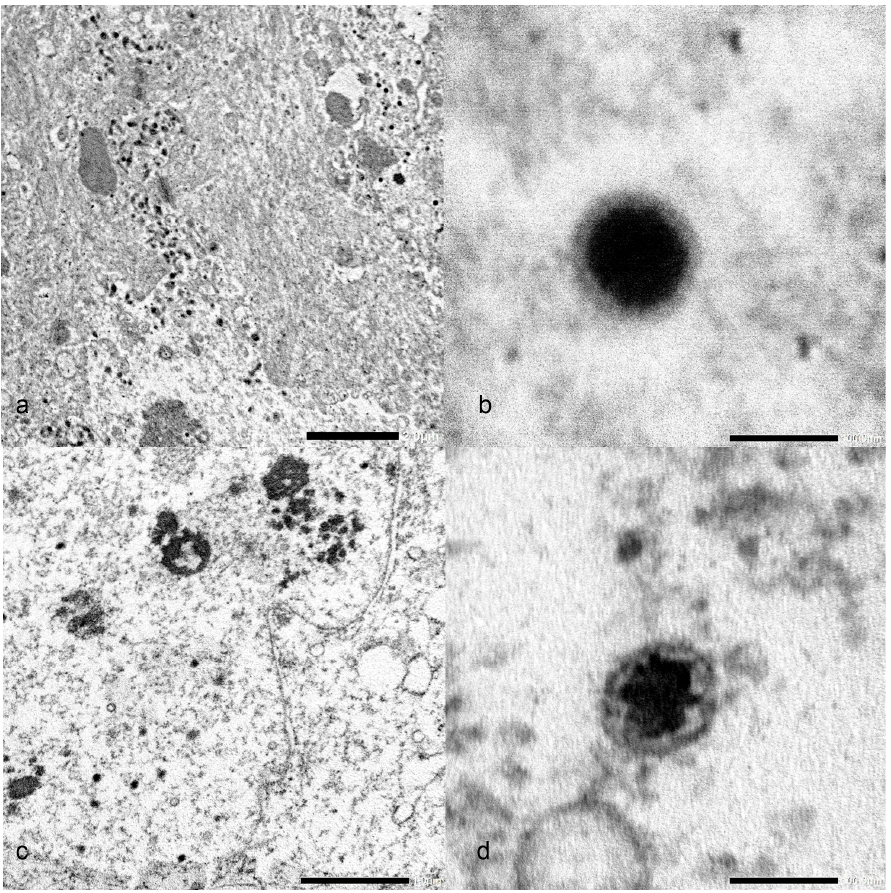
Figure 4 Figure 4. ( a ) Large numbers of herpesvirus particles (arrows) in degenerating nucleus of an epithelial cell in the stratum spinosum of the epidermis. bar = 2 µ m ( b ) Higher magnification of mature 85 nm virion (C-capsid) from skin lesion. bar = 100 nm ( c ) Large numbers of herpesvirus particles (arrows) in degenerating nucleus of affected cell in cell culture. bar = 1 µ m ( d ) Higher magnification of mature 85 nm virion from cell culture. bar = 100